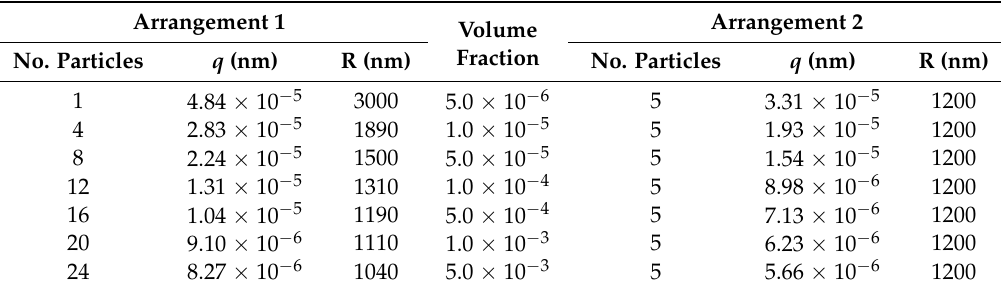
Table 2. Number of particles and their radii along with sample space side ( q ) in the first three columns. Similar data is shown for fixed particle size arrangement in the last three columns. The center column contains the volume fraction values common to both arrangements.